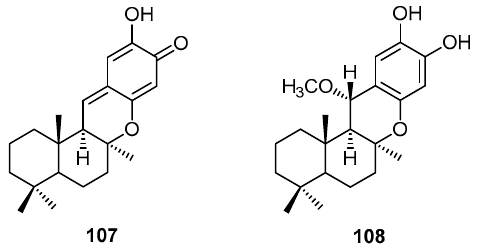
Figure 25. Chemical structures of puupehenone ( 107 ) and 15 α -methoxypuupehenol ( 108 ).